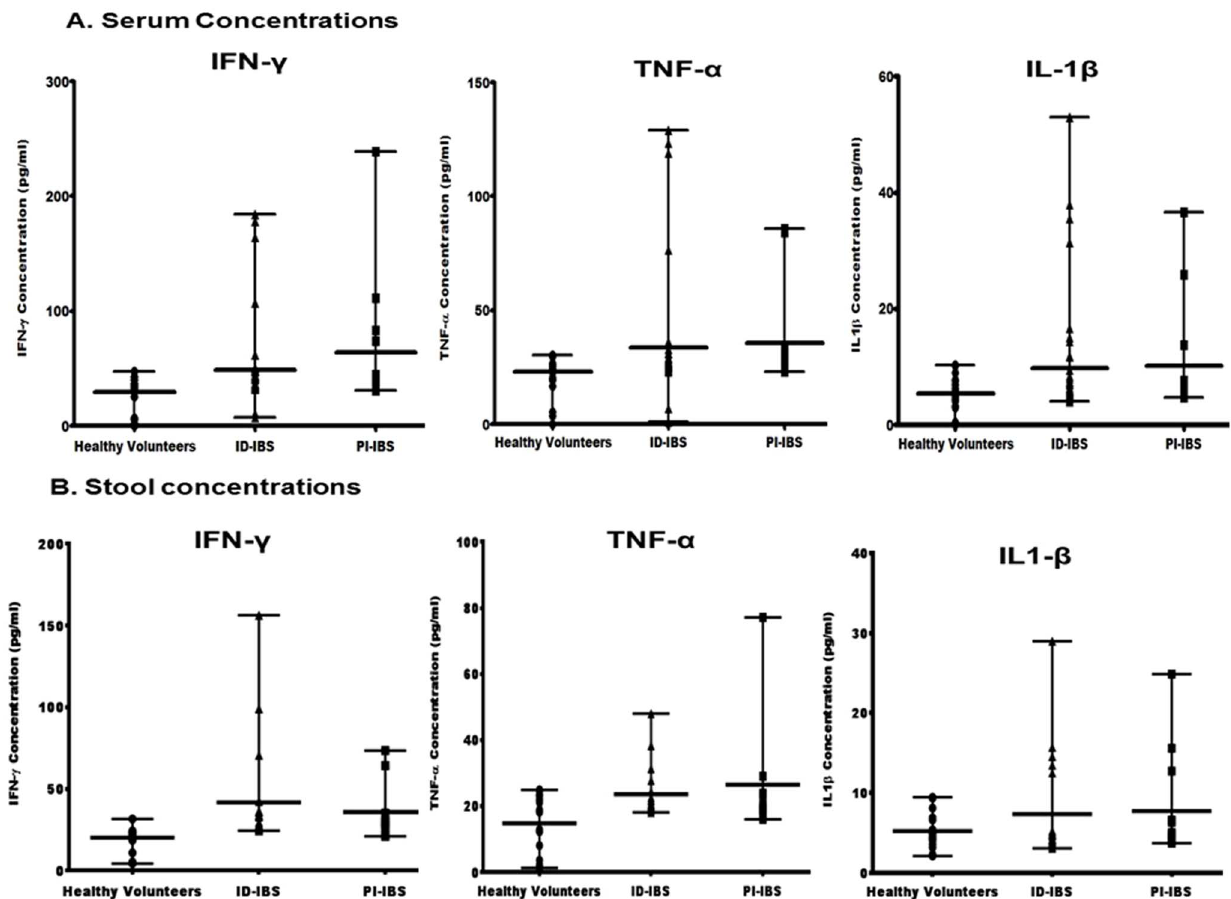
Figure 5. The sera and stools of IBS patients show significantly high levels of pro-inflammatory cytokines (IFN- c , TNF- a , and IL-1 b ). Sera and stools from IBS patients and healthy volunteers were analyzed for the concentrations of IFN- c , TNF- a , and IL-1 b by quantitative ELISA (R&D Systems, Minneapolis, MN). Mann Whitney test showed significant difference between the medians of the healthy volunteers versus ID-IBS (P , 0.0010) and PI-IBS (P , 0.0010) for IFN- c ; ID-IBS (p , 0.0001), PI-IBS (p , 0.0002) for TNF- a , ID-IBS (P , 0.0241) and PI-IBS (P , 0.0330) for IL-1 b . The medians of ID-IBS versus PI-IBS were not significantly different (P=0.1618 for IFN- c ; P=0.4958 for TNF- a ; and P=0.4135 for IL-1 b ). Error bars indicate median values with